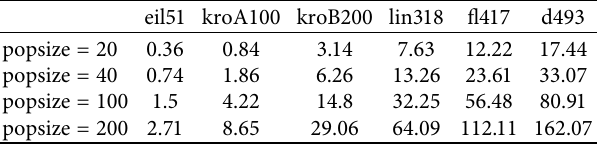
Table 4: Time consumption (millisecond per